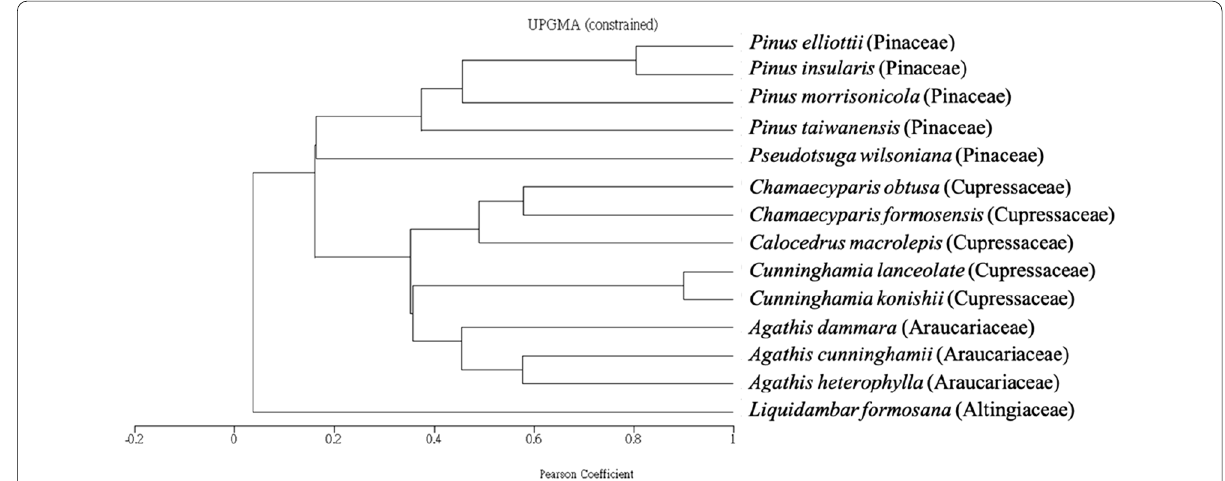
Fig. 8 Epigenetics of conifers relationship of 13 conifers grown in Taiwan by HSQC analysis of exudates